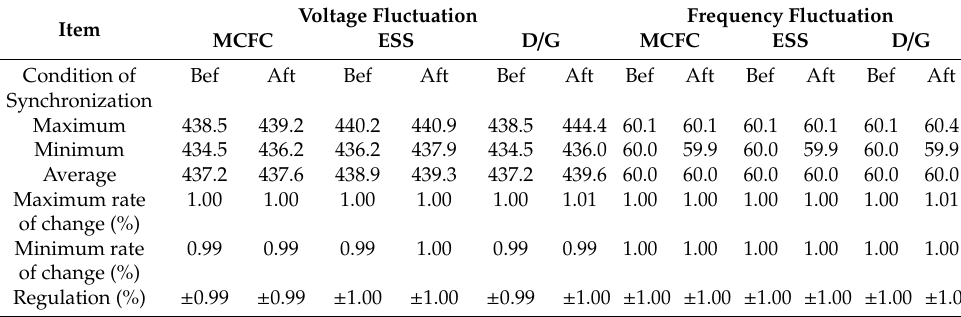
Table 13. Power data analysis before and after departing from the diesel generator system.